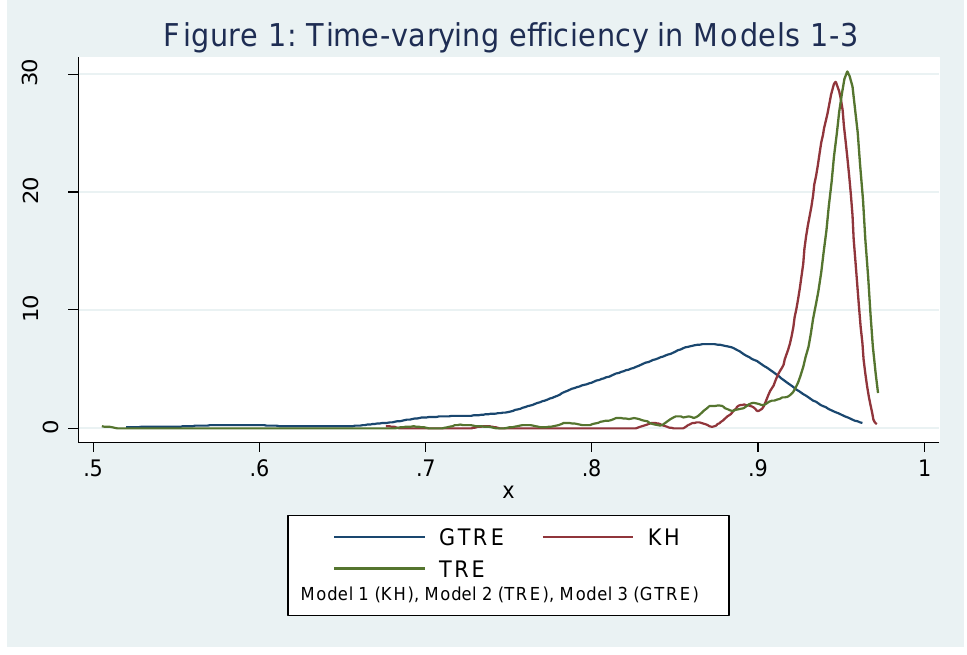
Figure 1. Time-Varying Efficiency in Models 1-3. Figure 2: Overall Efficiency in Models